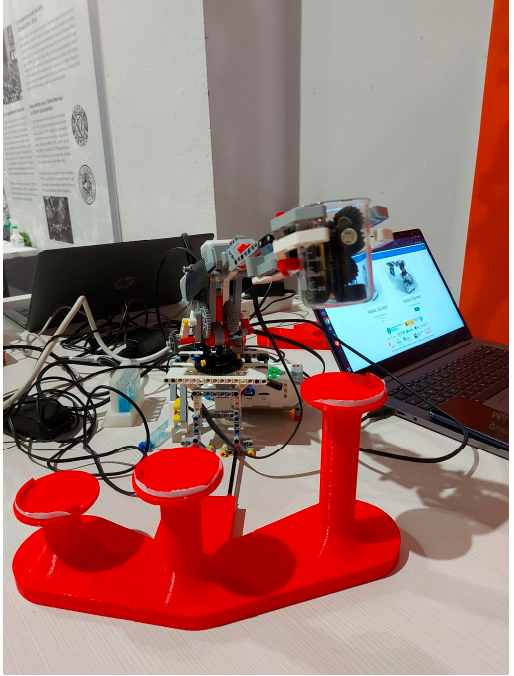
Figure 10. MultiArm Qui-Bot [32] equipped with a gripper for tipping cuvettes.